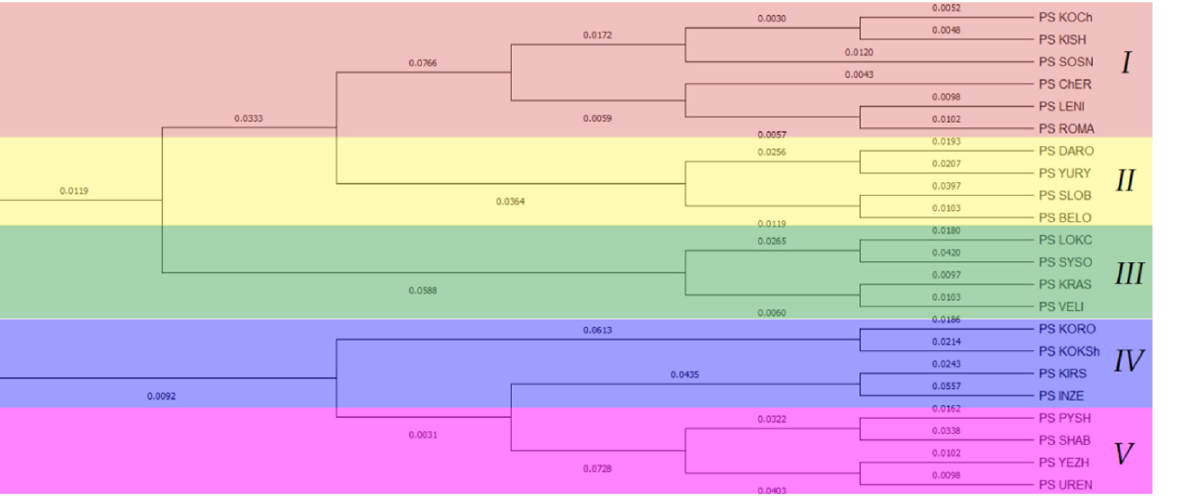
Figure 3. Distribution of individuals in the studied populations of Pinus sylvestris L. of the Middle Urals using UMAP. During the study of P. sylvesrtis populations, their spatial and genetic structure was checked for consistency with the “isolation-by-distance” model by the Mantel test. Thus, a pairwise comparison of all twenty-two studied populations revealed the presence of a weak positive correlation ( R 2 = 0.2534) between geographic and genetic distance ( D N ) (Fig- ure S5). A regression analysis was also carried out on these data, and a significant rela- tionship was found, but the R 2 value (0.2534) showed that the correlation was weak (Table S5). Using a specific and typical allele approach, populations in the studied regions were examined and characterized. The populations from the East European Plain are mostly characterized by the typicality of gene pools (GOC < 1.000); only the PS_INZE selection (GOC = 1.041) is characterized by the specificity of the gene pool . The populations from the Middle Urals, on the contrary, are more specific in gene pools (GOC > 1.200), the most specific gene pool belongs to the PS_KISH selection (GOC = 1.665).